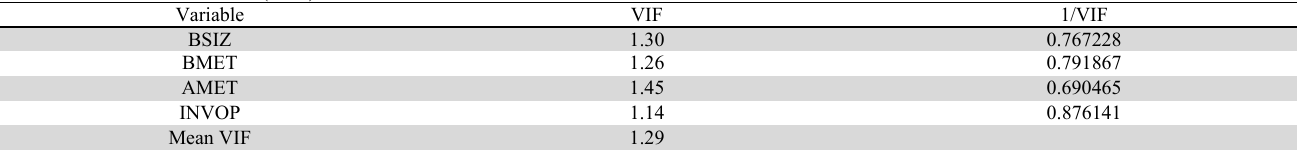
Variance Inflation Factors (VIF) test